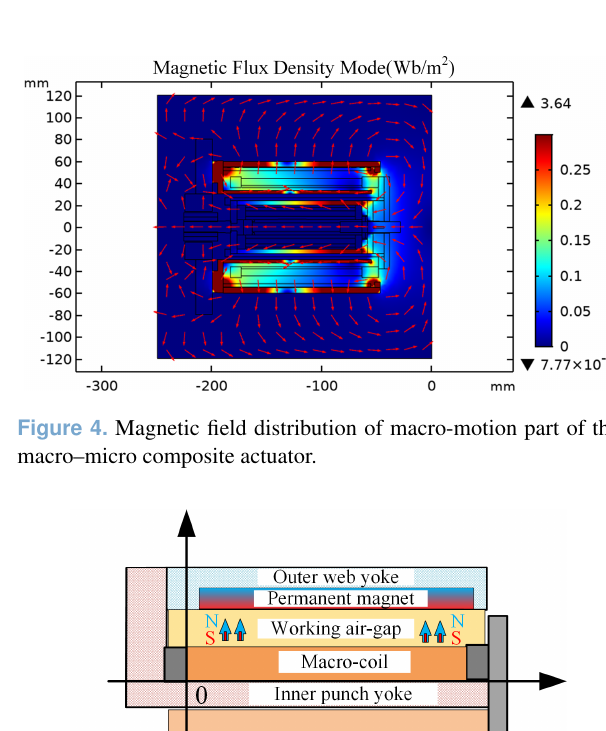
Figure 3. Diagram of the study workflow.